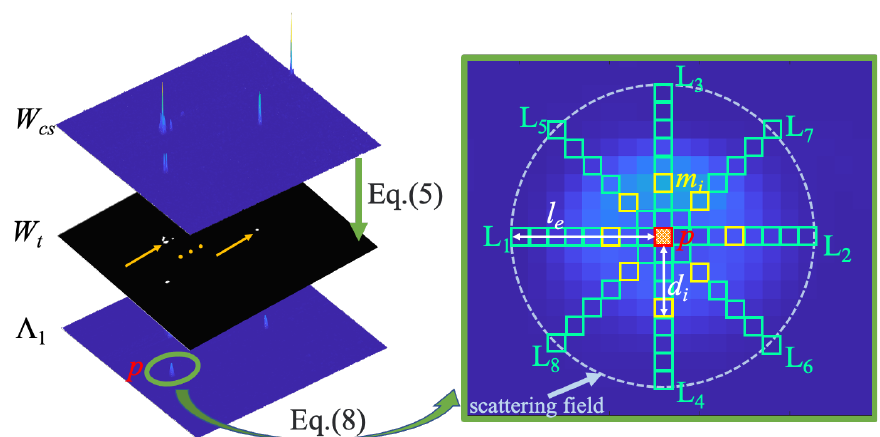
Figure 3. Schematic diagram of multidirectional uniformity of eigenvalue Λ 1